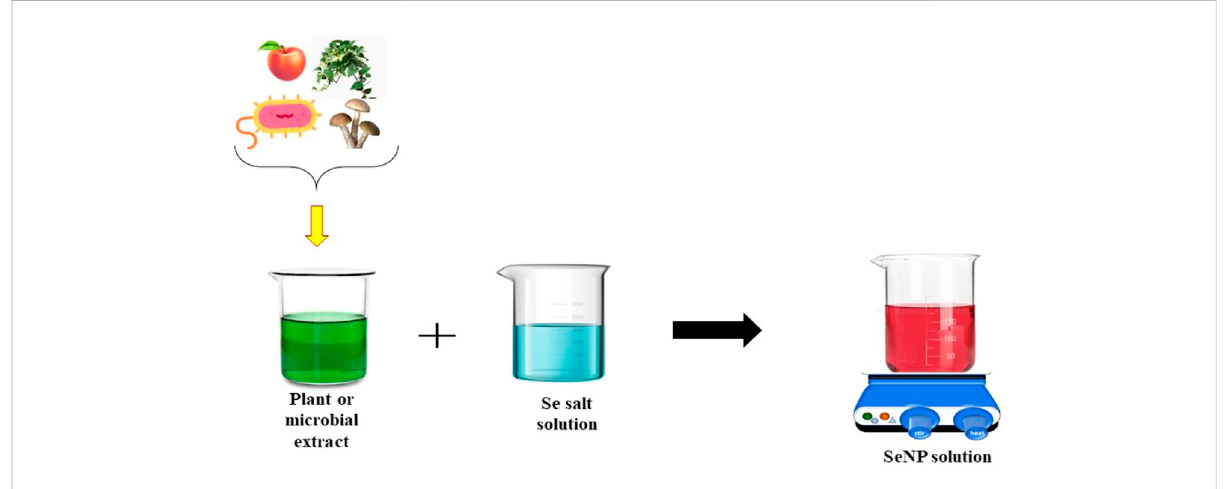
FIGURE 2 Schematic representation of the synthesis of SeNPs through biological routes [created based on Chhabria and Desai